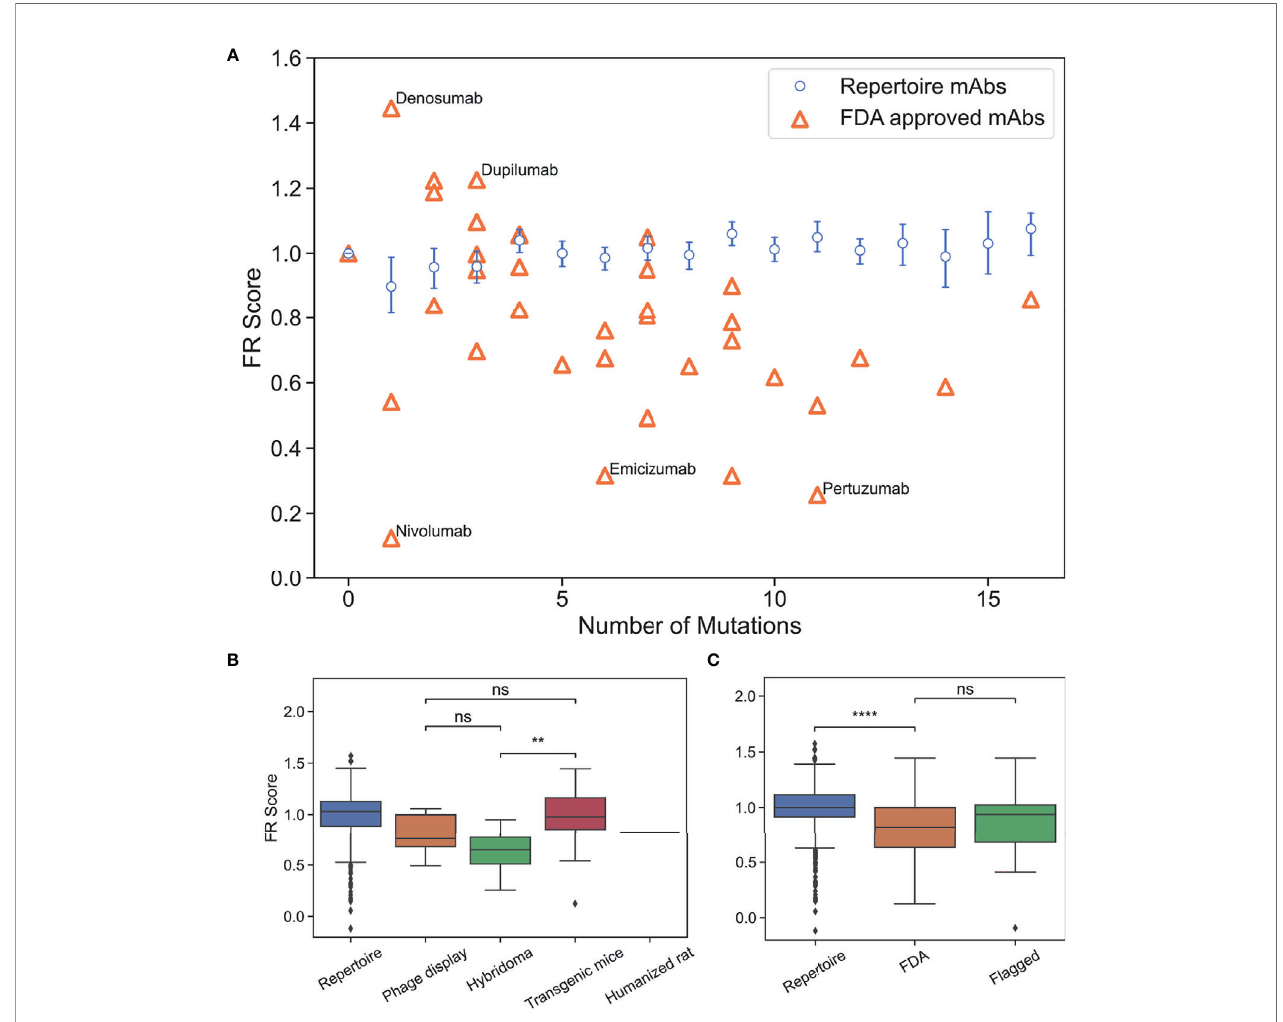
FIGURE 4 | FR scores of FDA-approved and fl agged mAbs are lower than typical human antibodies. (A) Comparison of FR scoresfor repertoire Abs and FDA-approved mAbs. Error bars on FR scores represent 95% con fi dence intervals. (B) FR scores of FDA-approved mAbs by development method. (C) FR scores of repertoire, FDA- approved, and fl agged mAbs. (ns, p > 0.05, **p < 1e-2, ****p <